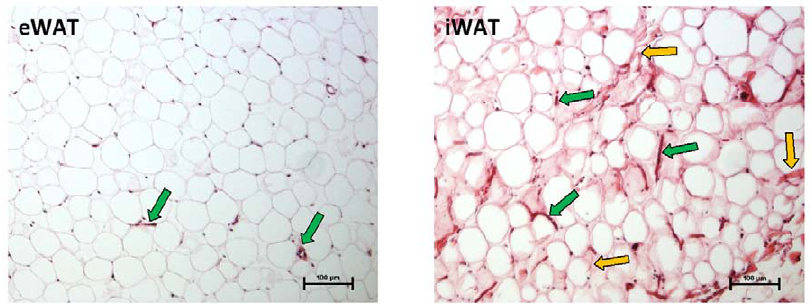
Figure 3. Histological characteristics of rat epididymal adipose tissue (eWAT) and inguinal adipose tissue (iWAT). Standard H&E staining of sections was performed. As compared with eWAT, less adipocytes, bigger intercellular space, more blood cells/vessels residue (deep red particles/tubes with green arrow) and abundant collagen fibers (light red filaments with yellow arrow) were seen in iWAT.